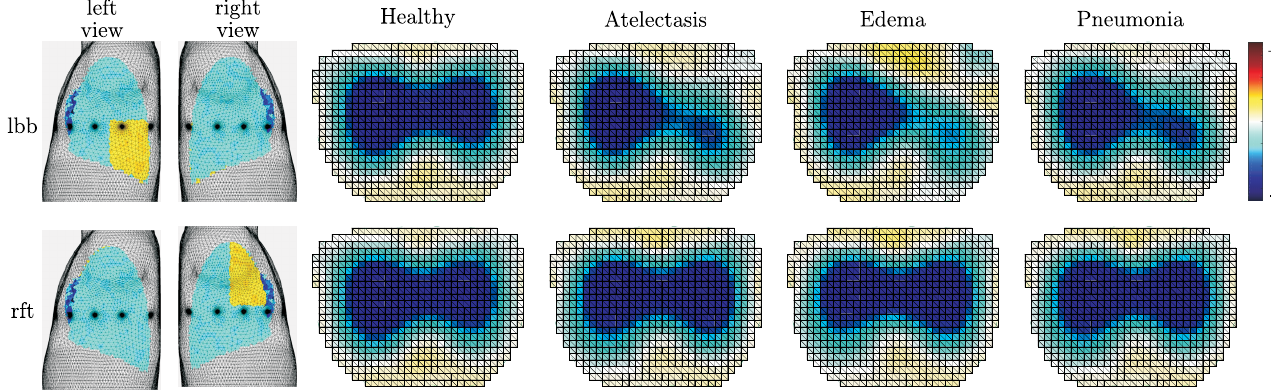
Fig.7: Reconstructed EIT images based on simulated pathologies. In the top row, the healthy reference and pathological examples for the left, back, bottom region of interest are presented. In the bottom row, the same healthy reference and pathology for the right, front, top region of interest is shown. The respective region is highlighted in yellow in the left and right view. It can be seen that in the lbb case, a high inhomogeneity can be observed whereas in the rft case, almost no impact on the EIT image is visible.